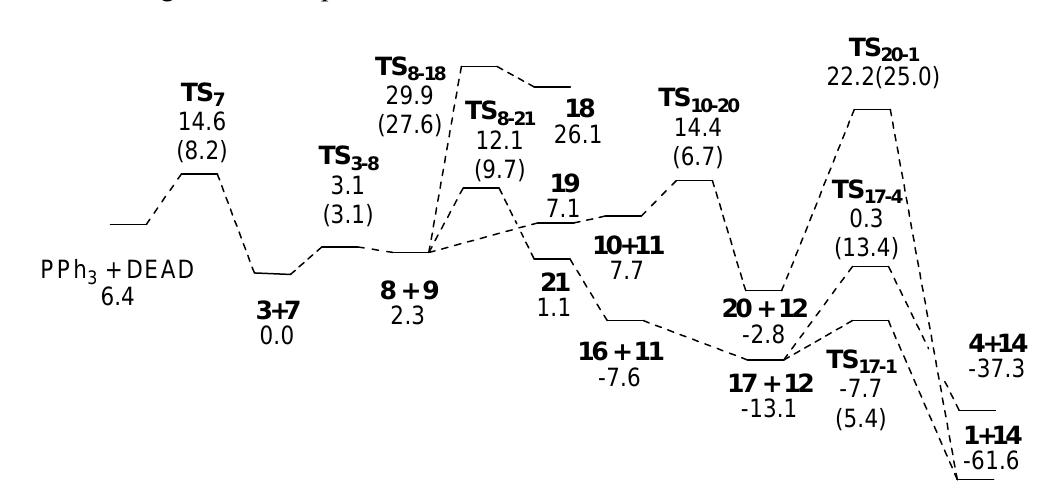
Figure 2. Energy correlation diagram (kcal mol -1 ) of the Mitsunobu reaction of 3 . Values in the diagram are energies relative to that of 3+7 . The numbers in parentheses are activation energies for each